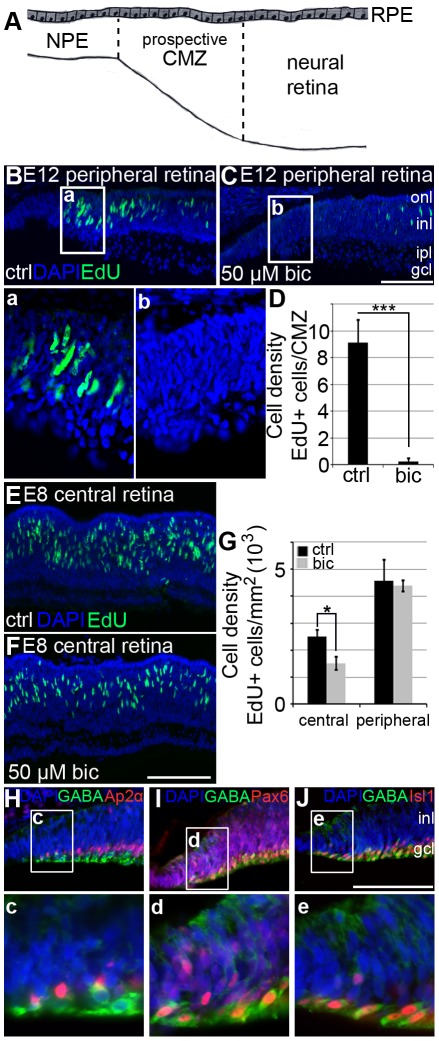
GABAA receptor mediated effects on retinal progenitor cell proliferation.(A) Schematic diagram of the E12 peripheral retina. Cells between the dashed lines in the prospective ciliary marginal zone (CMZ) on the dorsal side of the retina were counted. Cells that had gone through S-phase were detected by EdU labelling. Fluorescence micrographs of EdU labelled cells in (B) untreated (control) and (C) bicuculline-treated E12 retinal explants cultured for 4 hours. Images in (a) and (b) show the boxed regions in (B) and (C). (D) Bar graph shows the cell density of EdU positive cells per CMZ in control and bicuculline-treated explants. Error bars ± S.D. n = 4 explant cultures, average of 4 sections per explant, two-tailed Student t-test; *** p<0.001. Fluorescence micrographs of EdU labelled cells in the central retina in (E) control and (F) bicuculline-treated E8 explants cultured for 4 hours. (G) Bar graph shows cell density of EdU positive cells in central and peripheral retina in control (black bars) and bicuculline-treated (grey bars) E8 explants. Error bars ± S.D. n = 3 explants cultures, average of 4 sections per explant, Mann-Whitney test; * p = 0.05. (H–J) GABA+ cells close and within the prospective CMZ labelled for (H) Ap2α, (I) Pax6 or (J) Isl1. Images in (c) to (e) show the boxed regions in (H–J) in higher magnification. gcl, ganglion cell layer; inl, inner nuclear layer; ipl, inner plexiform layer; onl, outer nuclear layer; RPE, retinal pigment epithelium. Scale bar in (C) is 100 µm and is valid for (B). Scale bar in (F) is 100 µm and is valid for (E). Scale bar in (J) is 100 µm is valid for (H–J).